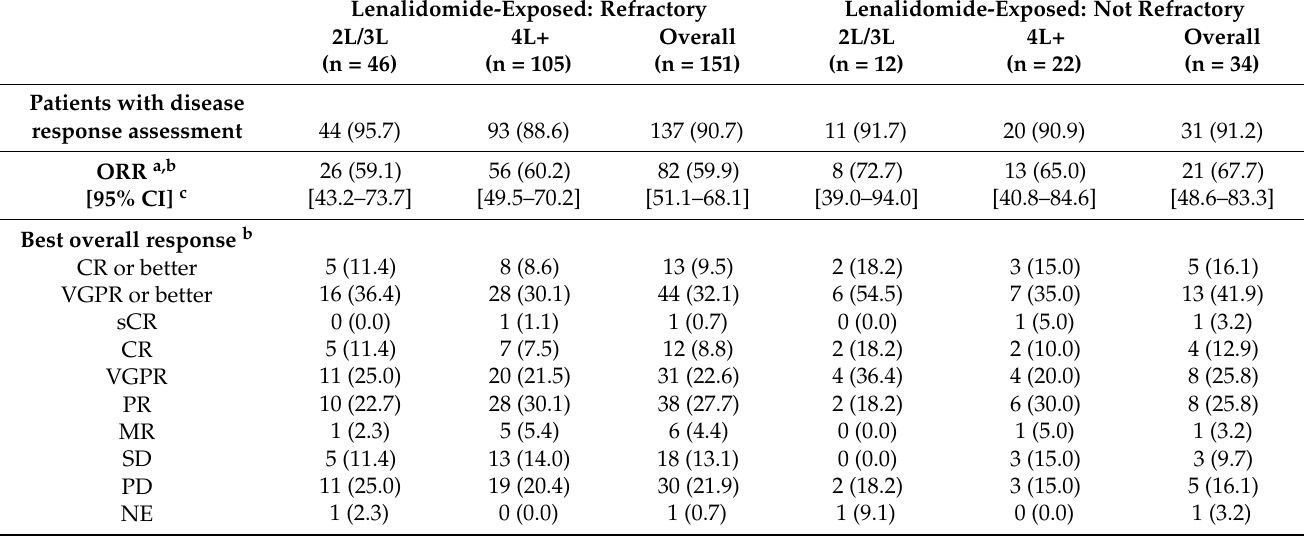
Table 3. Treatment response to Kd for lenalidomide-exposed patients. Lenalidomide-Exposed: Refractory Lenalidomide-Exposed: